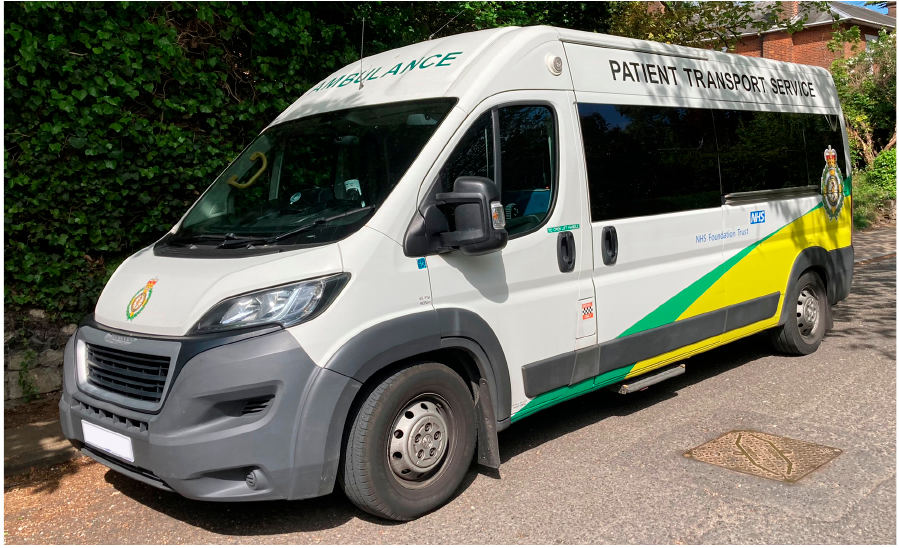
Figure 1. Patient Transport Service (PTS) vehicle .